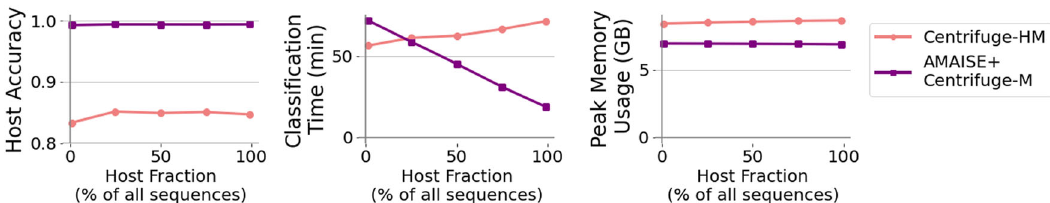
Fig. 4 Performance of Centrifuge-HM and AMAISE + Centrifuge-M across samples that varied in terms of host percentage. Across samples that varied in terms of host percentage, the pipeline that included AMAISE consistently achieved a higher host accuracy while requiring less peak memory usage and remaining competitive with respect to classi fi cation time. Notably, AMAISE + Centrifuge-M ’ s classi fi cation time decreased as the percentage of host data in the test set increased, while Centrifuge-HM ’ s classi fi cation